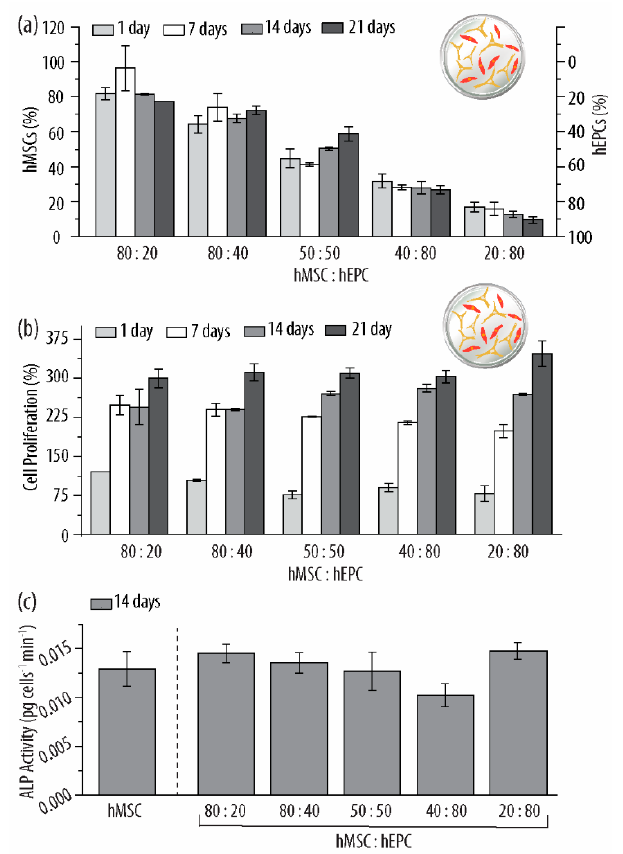
Figure 5. ( a ) Percentage of human mesenchymal stem cells (hMSCs) and human endothelial progenitor cells (hEPCs) for different seeding ratios after 1, 7, 14 and 21 days of co-culture; ( b ) proliferation of co-cultured hMSCs and hEPCs depending on the seeding ratio for different co-culturing time intervals; and ( c ) Alkaline phosphatase (ALP) activity readings of hMSCs and hEPCs co-cultured for 14 days at a 50:50 seeding ratio: The cells had been cultured onto PCL/HA scaffolds coated with polydopamine (PDA) layers entrapping both BMP-2 (B) and VEGF (V) growth in two different PDA layers (PDA@B/PDA@V). A dithiol connecting linker has been added to allow for the deposition of two PDA layers.